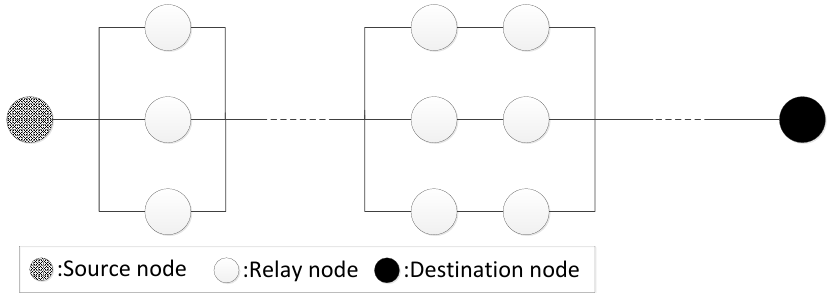
Figure 3. Route in wireless sensor networks (WSNs) based on the serial–parallel